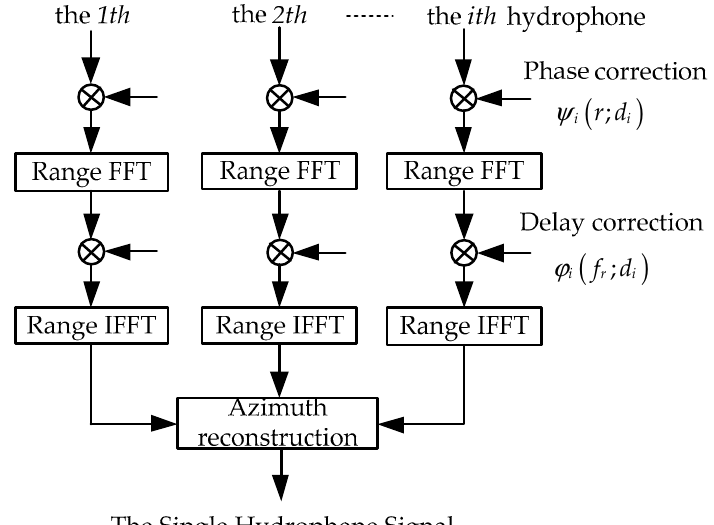
Figure 3. Flow chart of correction.